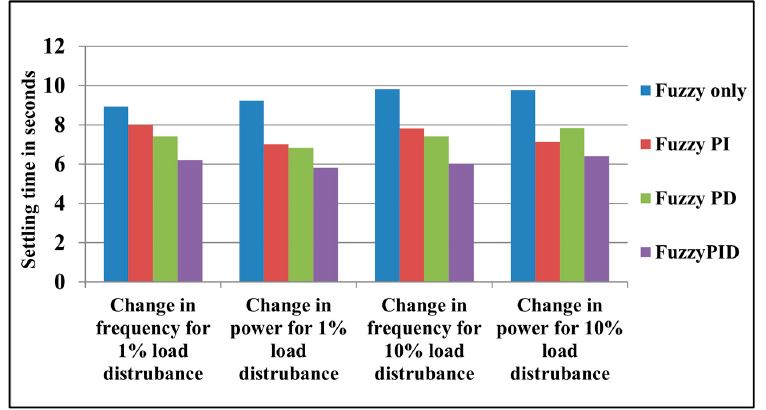
Figure 17. Comparison of dynamic responses of the hybrid system in terms of settling time for frequency and change in power of the hybrid system with Fuzzy, Fuzzy-PI, Fuzzy-PD and Fuzzy -PID against different load disturbances.